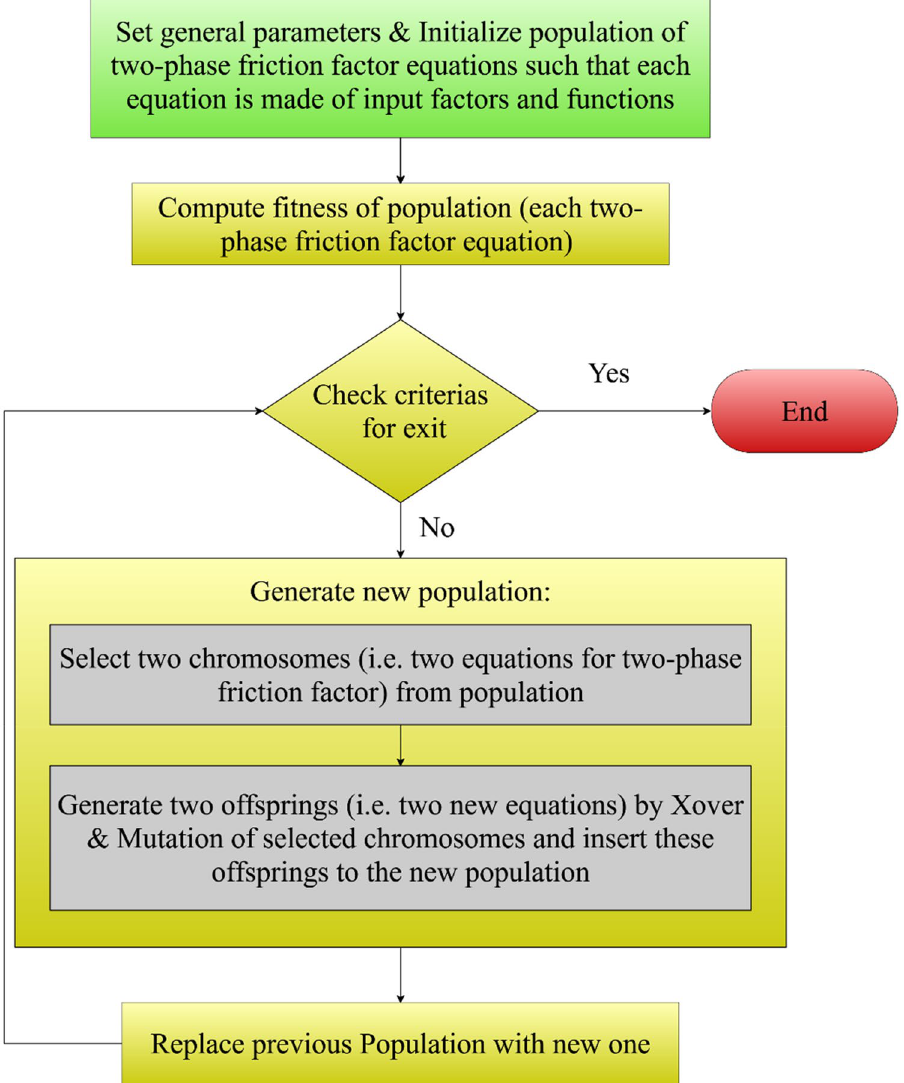
Figure 2. Flowchart of GP approach used for modeling of the two-phase FPD in coiled